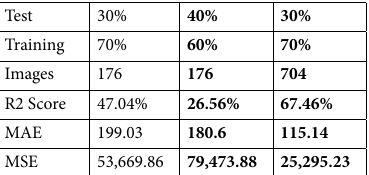
Table 3. Parameters changed to evaluate the accuracy of the CNN model—Huh7 cell line.